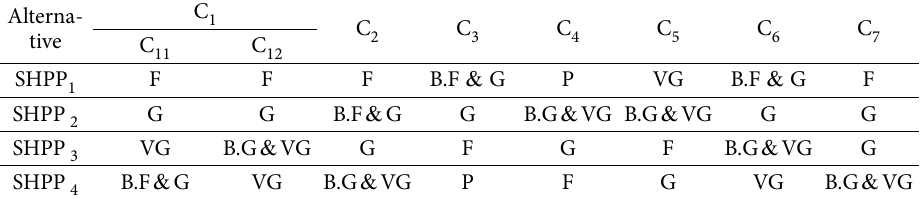
Table 2. SR data in terms of TrFNs Alterna- tive